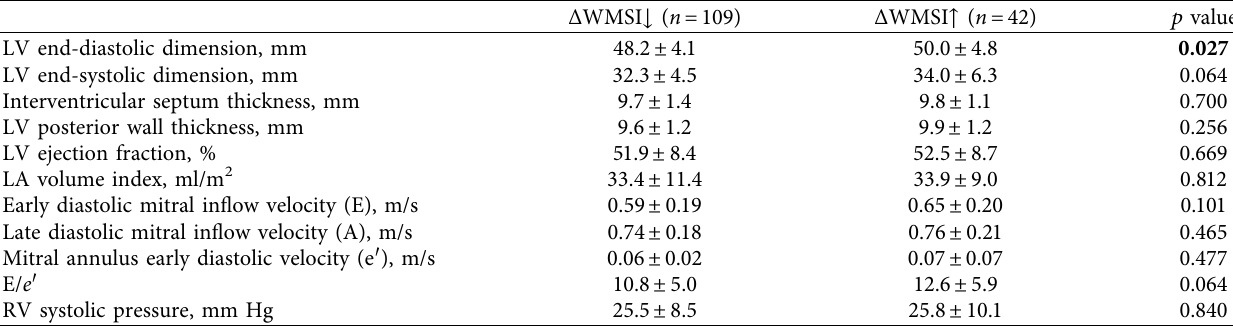
Table 2: Echocardiographic